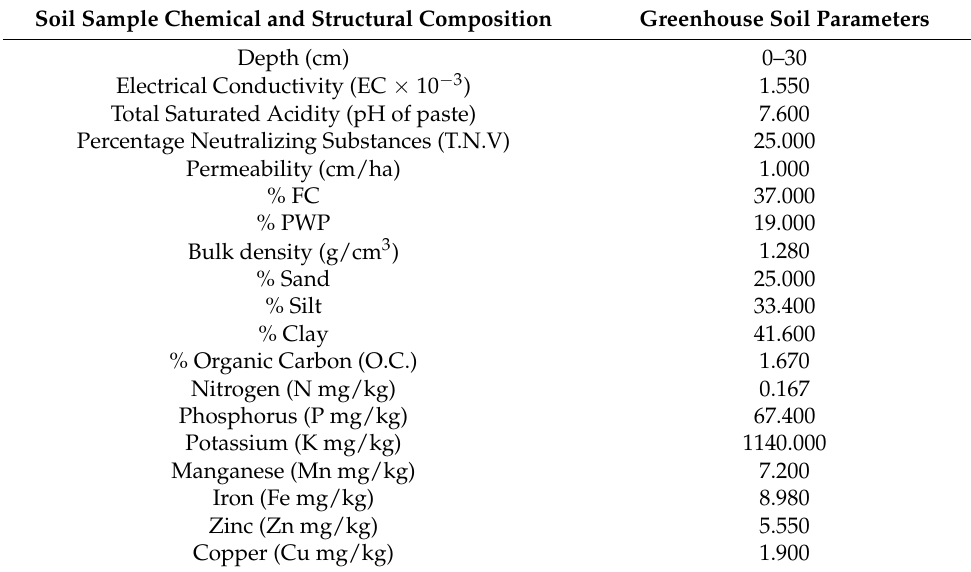
Table 1. Characteristics of greenhouse soil used for cucumber plant